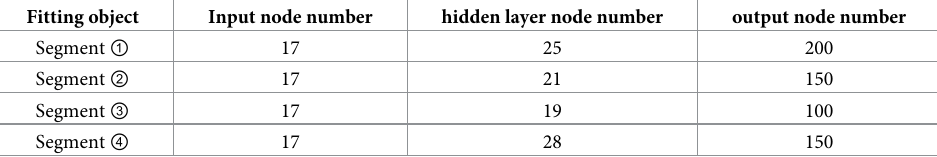
Table 6. Design of the neural networks for the fitting of the frequency response characteristics.